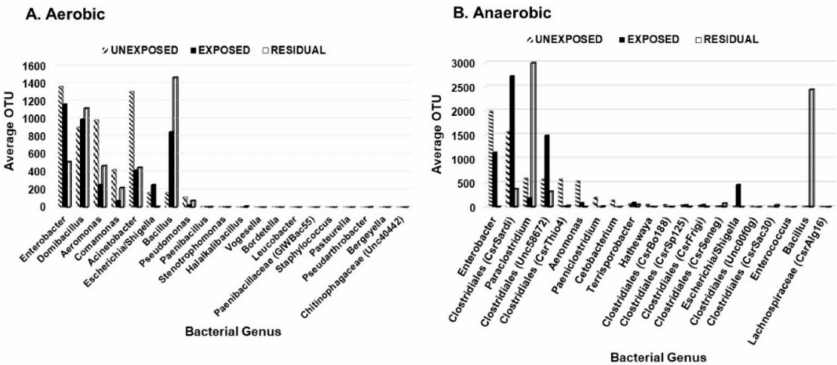
Figure 3. Distribution of the 20 most prevalent genera based on the region of pesticide exposure. ( A ) aerobic bacteria; ( B ) anaerobic